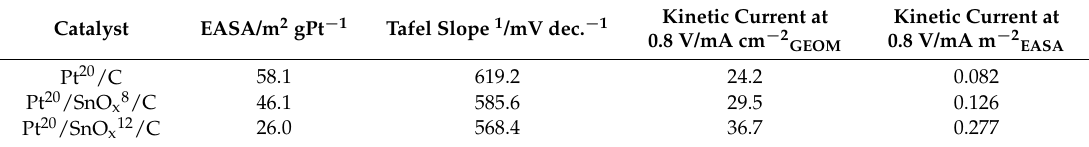
Table 2. Catalyst activity parameters.